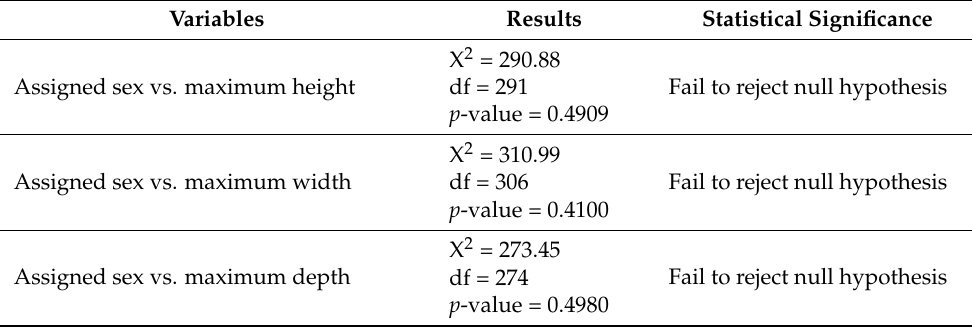
Table 2. Pearson’s chi-square tests of assigned sex and population affinity vs. the dimensional variables (maximum height, maximum width, maximum depth, and H × W × D). Variables Results Statistical Significance X 2 = 290.88 Assigned sex vs. maximum height Fail to reject null hypothesis df = 291 p -value = 0.4909 X 2 = 310.99 Assigned sex vs. maximum width Fail to reject null hypothesis df = 306 p -value = 0.4100 X 2 = 273.45 Assigned sex vs. maximum depth Fail to reject null df = 274 p -value = 0.4980